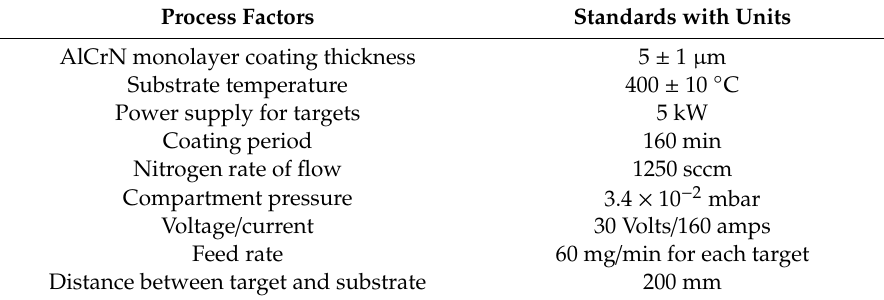
Figure 3. Microstructures of the as-sintered ( a ) Fe, ( b ) Fe–2 Cu ( c ) Fe–2Cu–0.8C, ( d ) Fe–2Cu–0.8C–0.2Mo, ( e ) Fe–2Cu–0.8C–0.4Mo and ( f ) Fe–2Cu–0.8C–0.6Mo, compacts consolidated in a Spark Plasma furnace at 1120 °C for 5 min. Table 2. CAP-PVD process parameters for AlCrN monolayer coating.